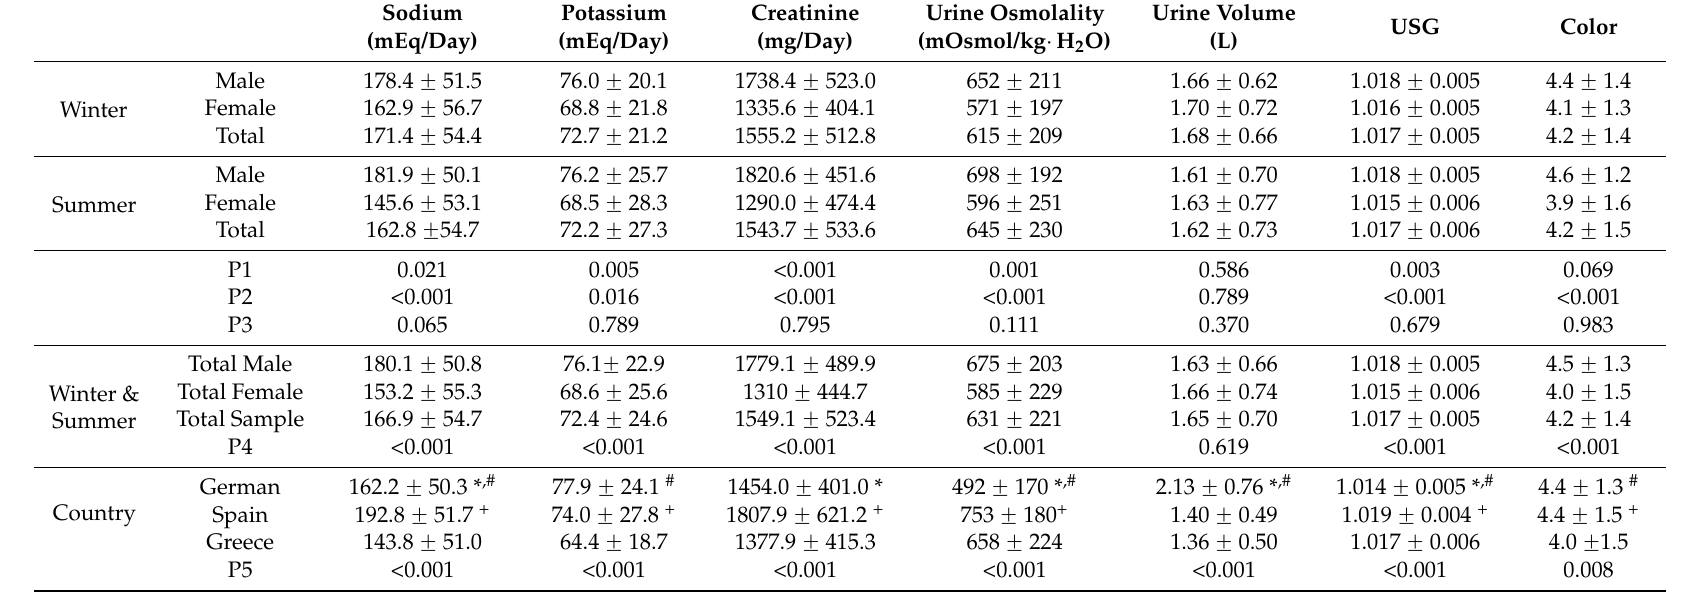
Table 1. 24 h urine hydration indices of participants in winter and